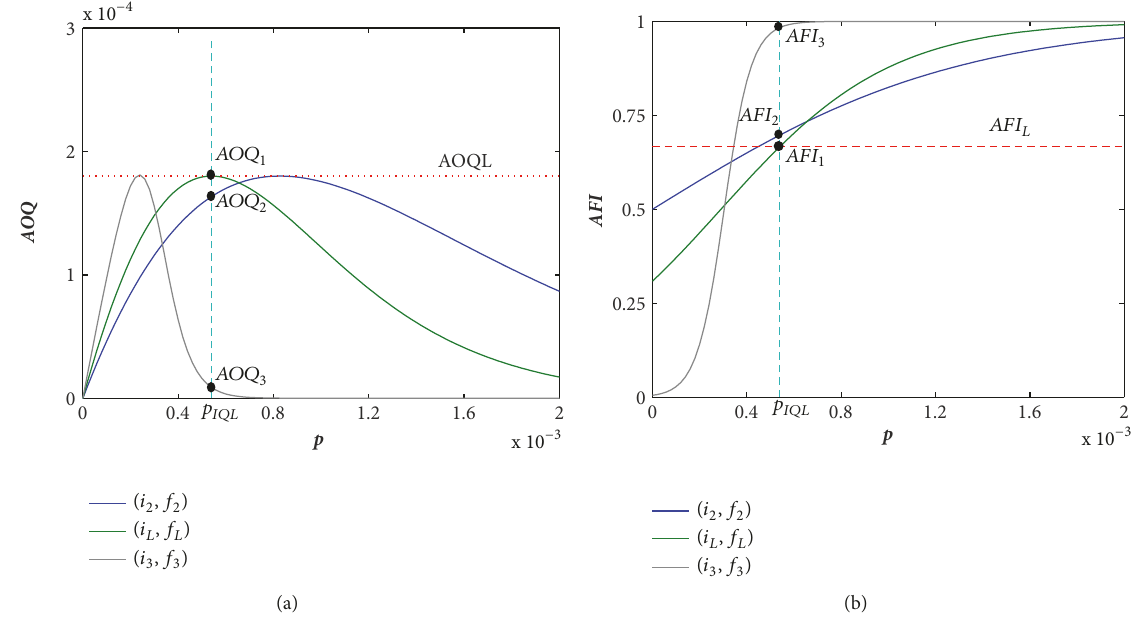
Figure 1: Comparisons of the curves of (a) 𝐴𝑂𝑄 and (b) 𝐴𝐹𝐼 between (𝑖 𝐿 ,𝑓 𝐿 ) and other two types of the AOQL contour